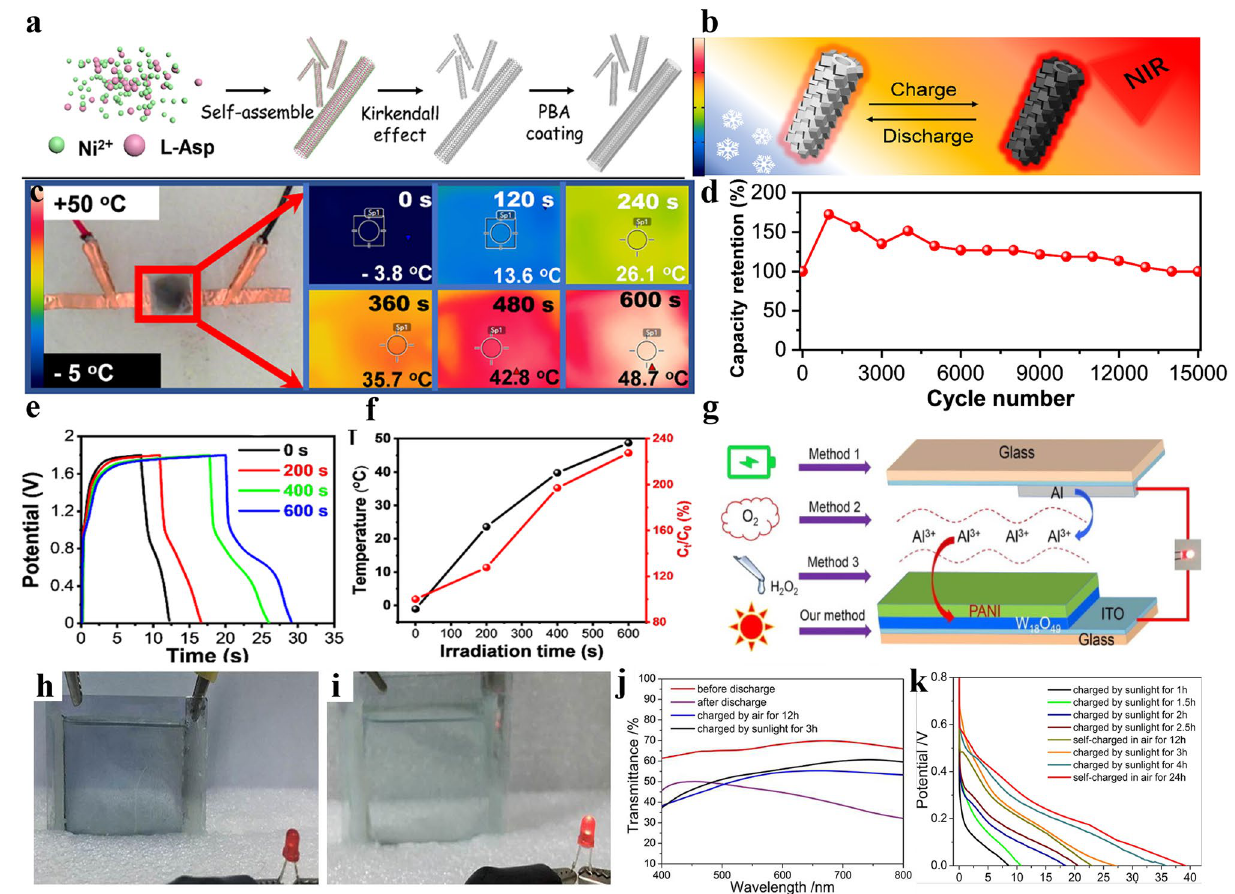
Fig. 14 Advances in multi-system conversion for MERABs. a Schematic of the preparation process of PBA/NiO electrode. b Schematic of electrochromical thermal-tuning effect of PBA/NiO electrode. c Infrared images of the PBA/NiO-based device under different solar irradiation times. d Cycling performance. e GCD curves. f Temperature and specific capacitance percentage under different solar irradiation times. Repro- duced with permission [36]. Copyright 2021, American Chemical Society. g Schematic of charging routes for W 18 O 49 /PANI electrochromic bat- tery. h W 18 O 49 /PANI electrochromic battery in colored state with energy exhausted. i W 18 O 49 /PANI electrochromic battery charged by sunlight irradiation for 3 h. j In-situ transmittance spectra, and k GCD curves by different charge methods. Reproduced with permission [152]. Copyright 2018,